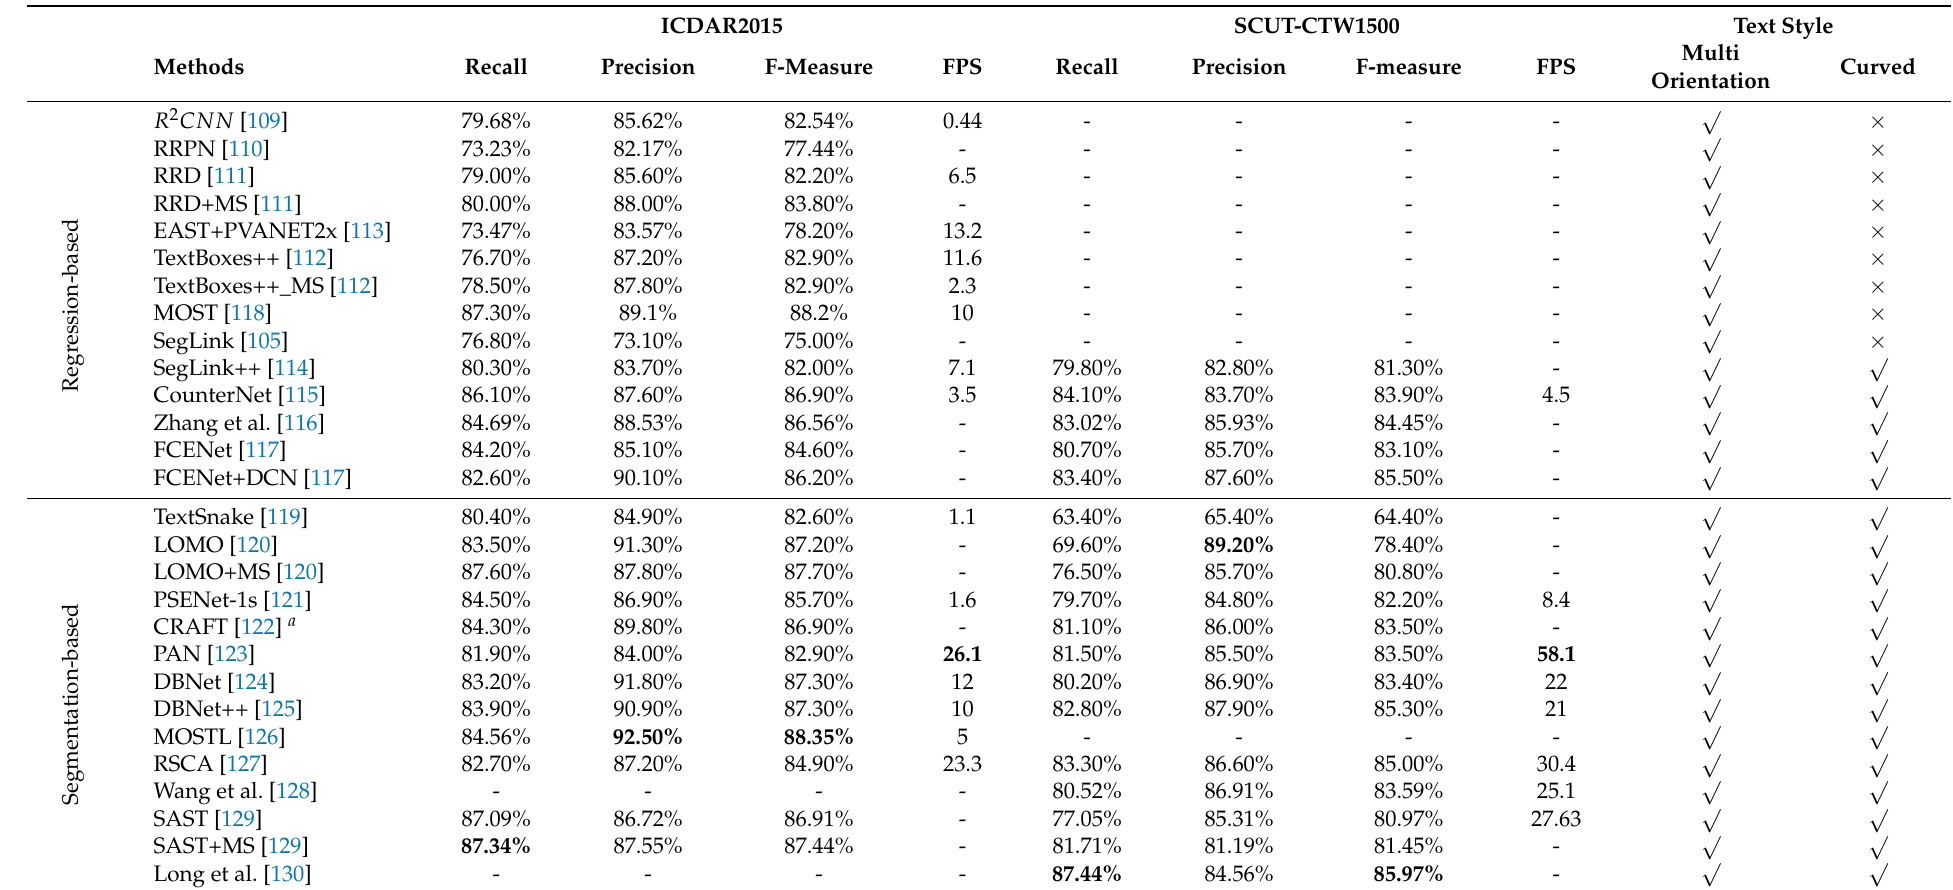
Table 7. Quantitive results of text detection methods on ICDAR15 and SCUT-CTW1500 datasets. “MS” is the abbreviation of multi-scale inputs. FPS are indicative values since the methods run in different environments. Bold numbers represent the best